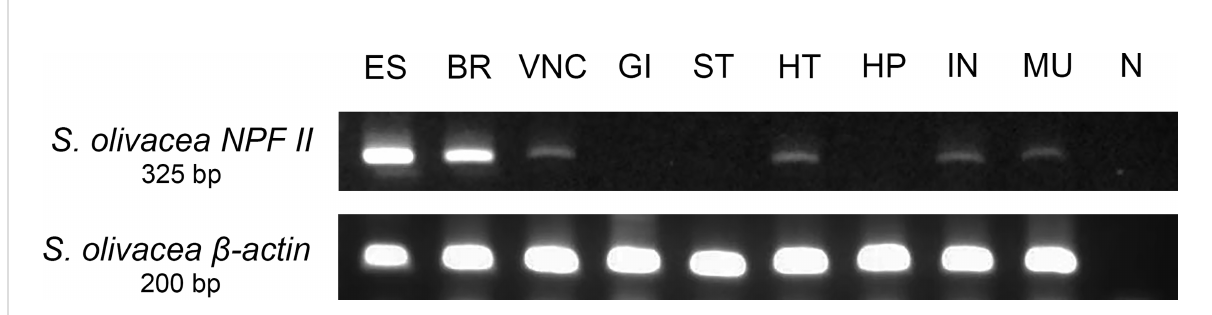
FIGURE 9 Tissue-speci fi c relative abundances of S. olivacea NPF II mRNA transcript in mature female using RT-PCR; S. olivacea NPF II mRNA transcript is detected in the eyestalk (ES), brain (BR), ventral nerve cord (VNC), heart (HT), intestine (IN), muscle (MU), b -actin mRNA abundance was used as internal controls. ES , eyestalk; BR , brain; VNC , ventral nerve cord; OV , ovary; GI , gill; ST , stomach; HT , heart; HP , hepatopancreas; IN , intestine; MU , muscle and N negative control.